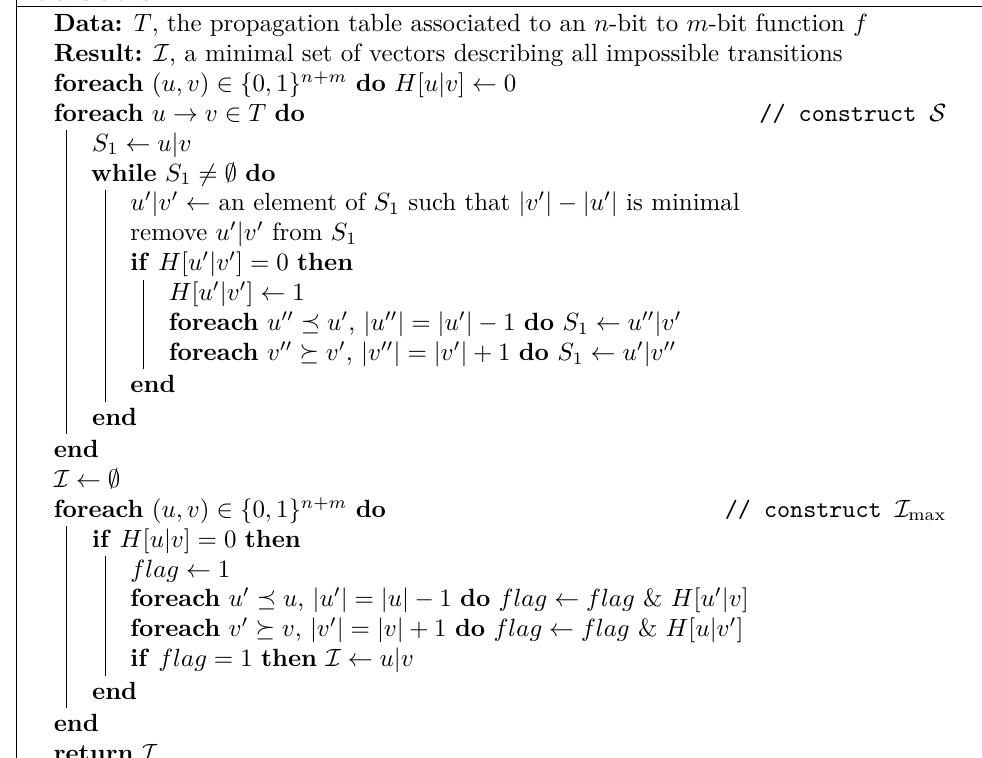
Algorithm 1: Computing a minimal set of vectors describing all impossible